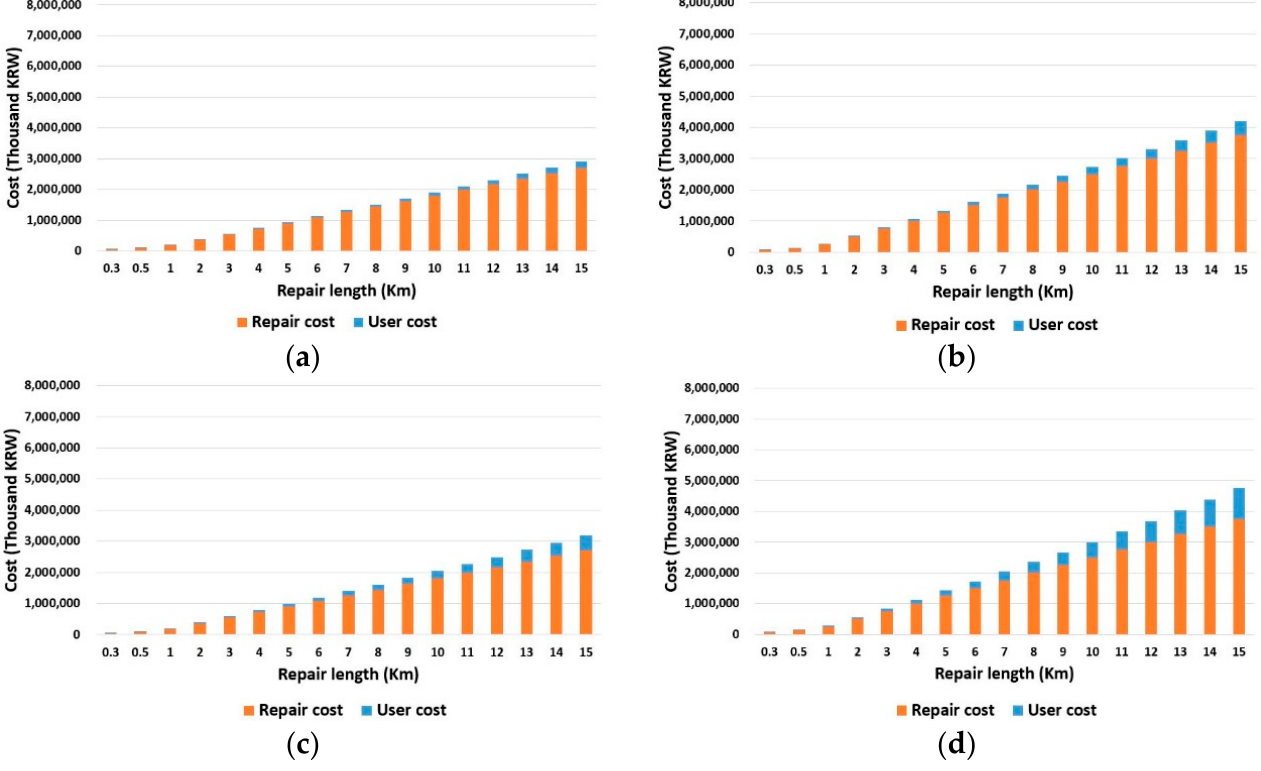
Figure 6. Total overlay Construction Cost (Lane 2). ( a ) Total cost of asphalt overlay (2-lane, shoulder road X, 6000 AADT). ( b ) Concrete Overlay Total Construction Cost (2-lane, shoulder road X, 6000 AADT). ( c ) Asphalt Overlay Total Construction Cost (2-lane, shoulder road X, 11,000 AADT). ( d ) Concrete Overlay Total Construction Cost (2-lane, shoulder road X, 11,000